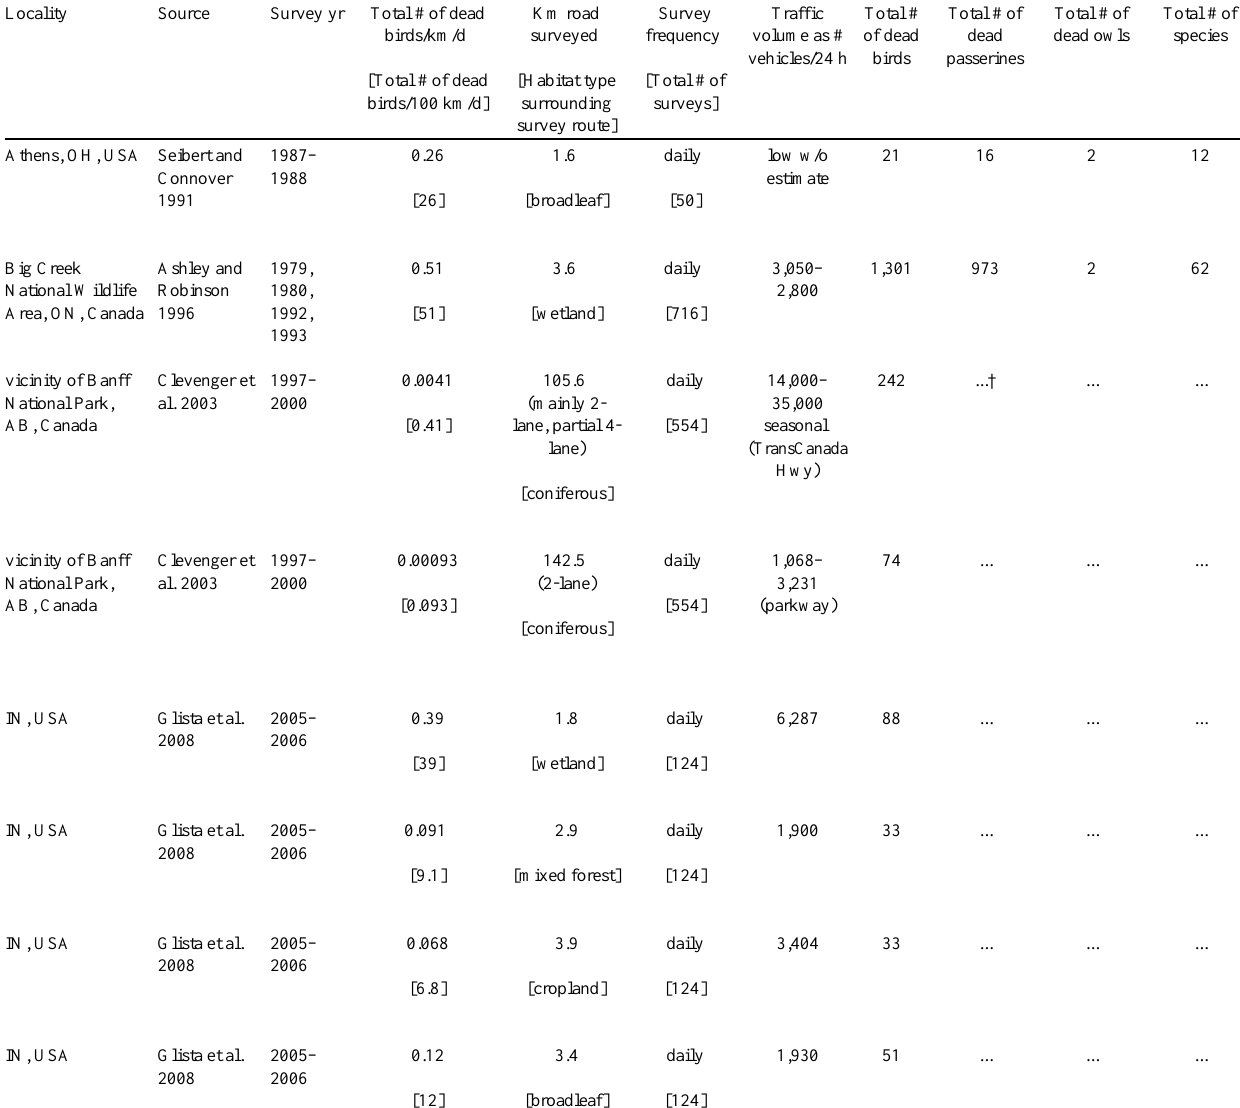
Table 2 . Surveys of avian mortality attributed to collisions with vehicles utilized in calculations of total birds killed/km/d on Canadian road